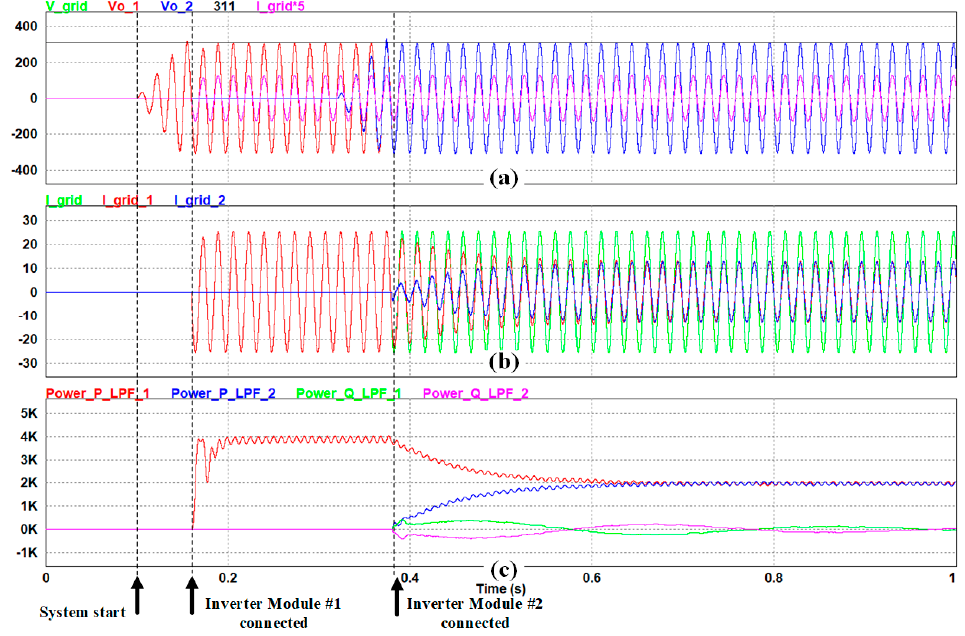
Figure 13. Simulation waveform of ( a ) grid voltage, ( b ) grid current, ( c ) and active and reactive